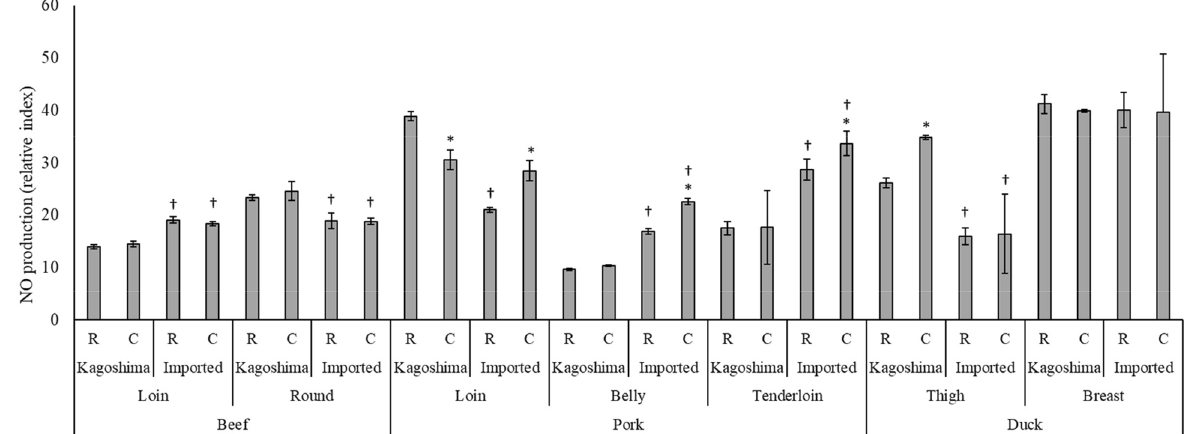
Figure 4. Effect of meat extract on nitric oxide production via vascular endothelial cells. R raw, C cooked. Asterisk indicates P < 0.05 vs. raw. Dagger indicates P < 0.05 vs. Kagoshima